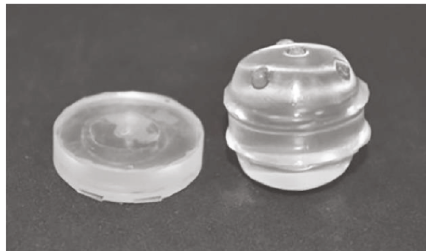
Figure 1: Self-in fl ating hygroscopic tissue expander (Oxtex Ltd.) before and after